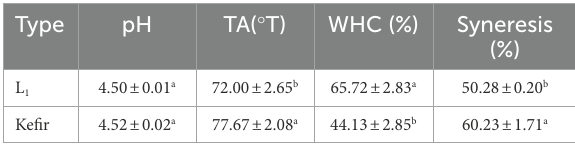
TABLE 1 Comparison of physicochemical indexes of different yoghurt groups.